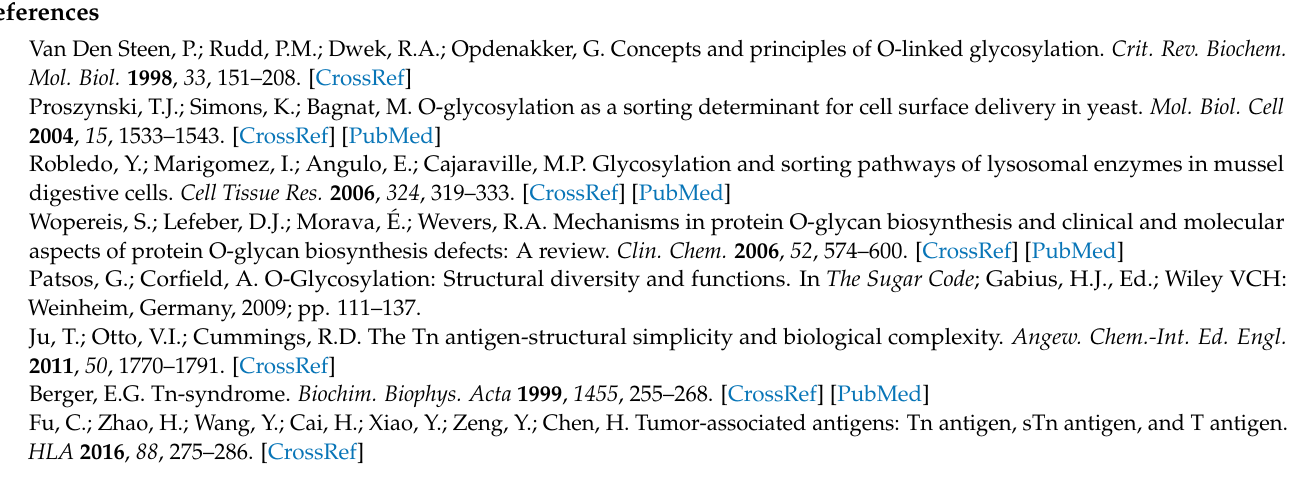
Figure S3: 1 H NMR of the incubation assay compared to 1 H NMR spectra of pNP-GalNAc, Gal- β - (1 → 3)GalNAc- α